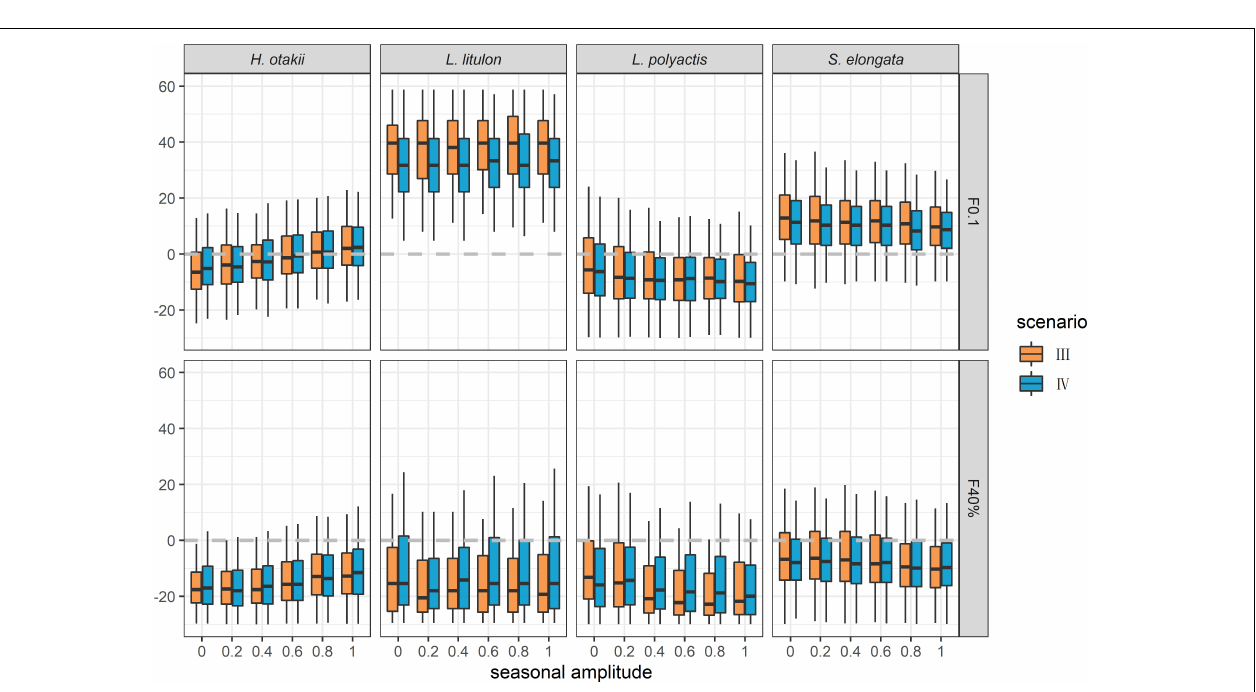
FIGURE 3 | Comparison of estimated BRPs between ignoring seasonality (scenario I) and considering seasonality falsely (scenario II) when seasonality was absent, shown as density plot. X -axis denotes the value of BRPs, Y -axis denotes the density of each value. The dashed gray lines indicate the “true” values in deterministic